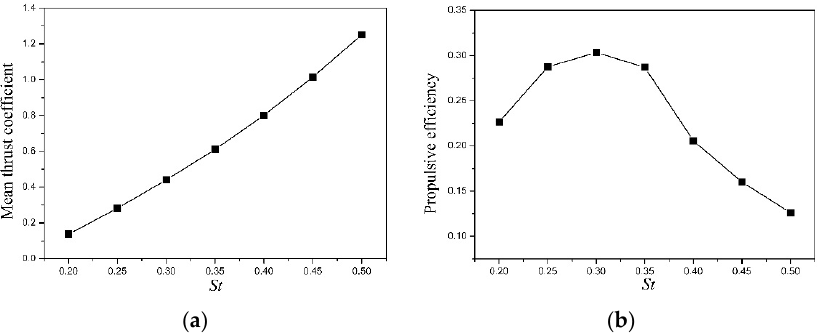
Figure 14. Performance curves versus Strouhal number: ( a ) mean thrust coefficient; ( b ) propulsive efficiency.